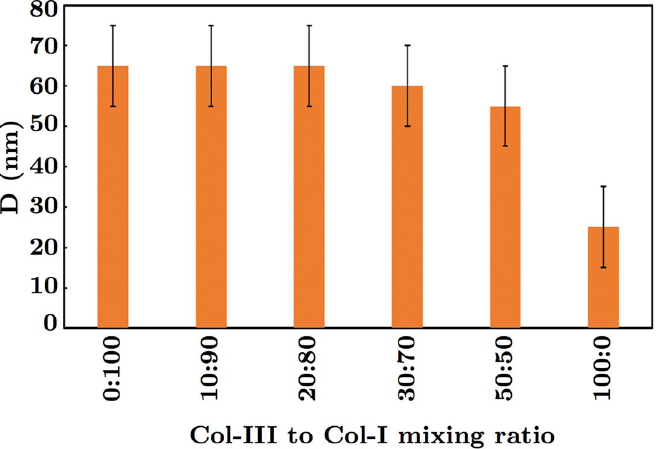
Figure 6. The graph of the measured axial periodicity (i.e., D-banding) D of collagen fibrils for different ratios of tropocollagen types I and III.